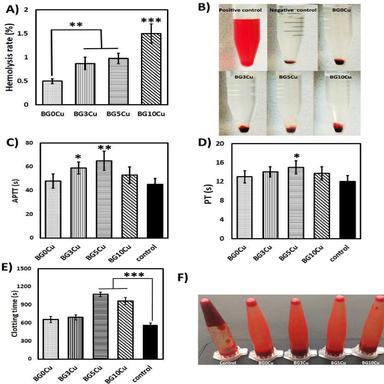
(A) The hemolysis rate of the modified bioactive glasses (BGs) with different amounts of Cu. (B) A photographic representation of the hemolysis test after centrifuging of the solutions. (C, D) The effect of the modified BGs with different amounts of Cu on the thromboplastin time and prothrombin time , respectively. (E) In vitro coagulation time of the modified BGs. (F) The process of blood clotting was photographed while a clot formed in the control group but did not in the other samples. Data provided as m